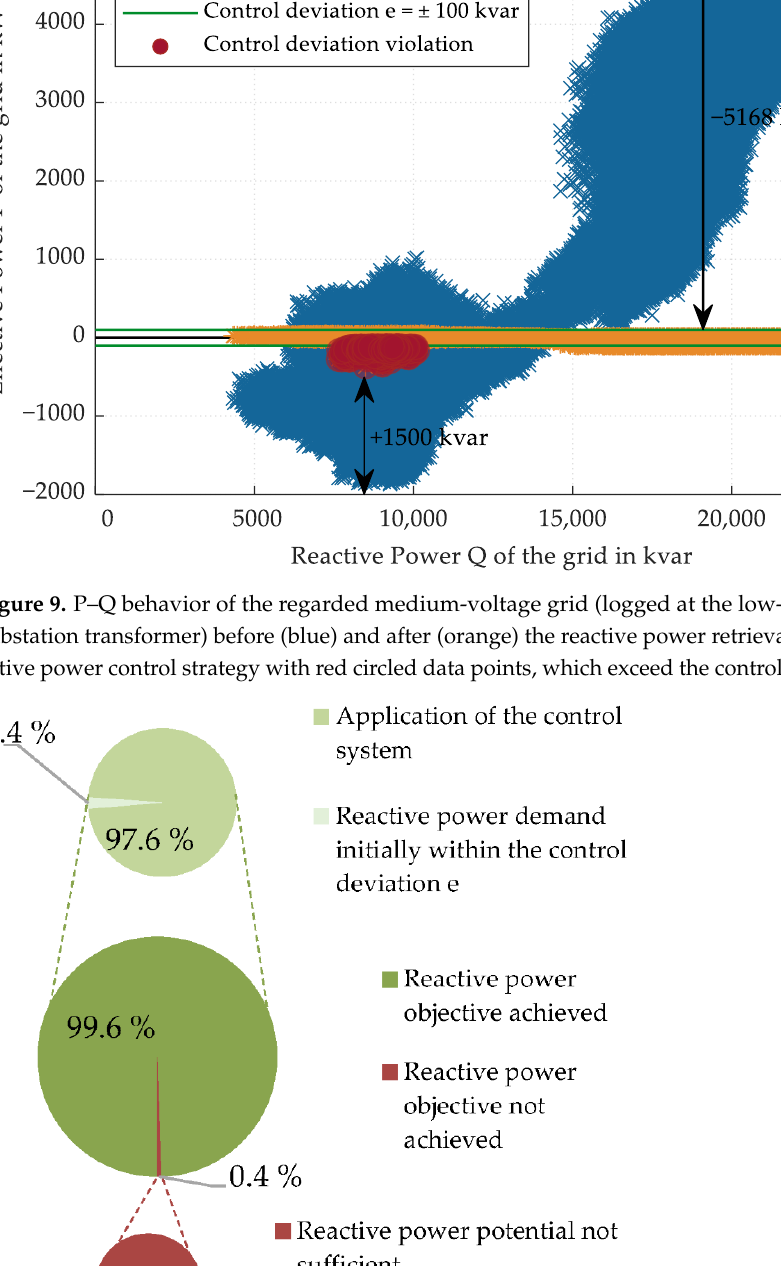
Table 3. Comparison between minimal simultaneous and non-simultaneous reactive power po- tential.